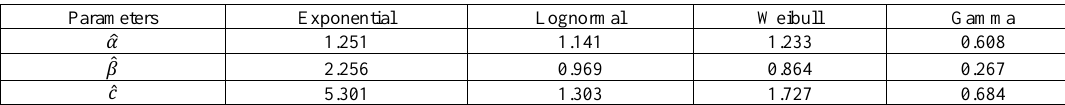
Table 5. The AD statistic of parameters by different distribution.